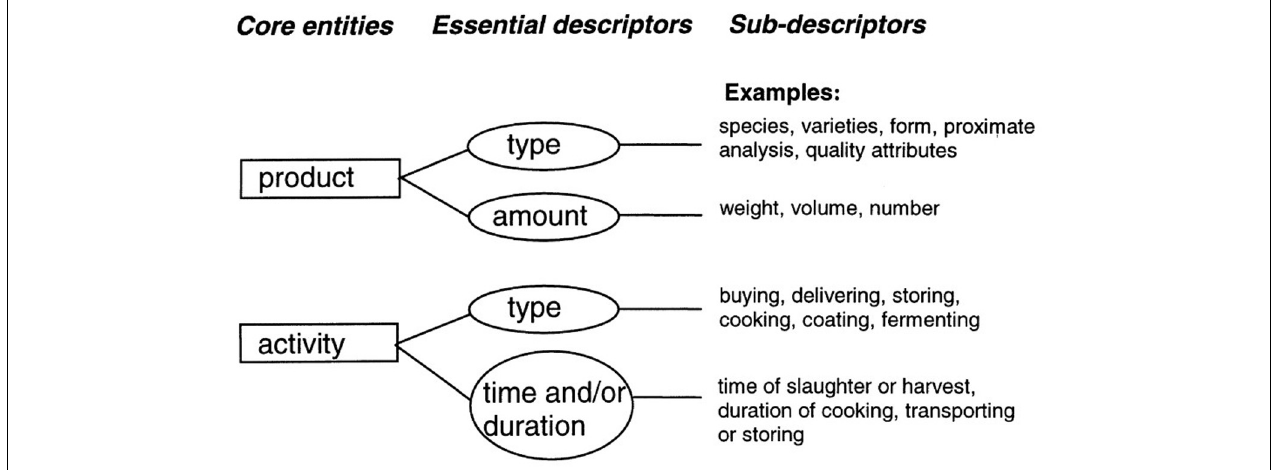
FIGURE 1 | Fundamental structure of a traceability system. Reprinted from “Perspectives on Traceability in Food Manufacture,” by Moe, 1998, Trends in Food Science and Technology, 9 (5), 211–214. Copyright 1998 by Elsevier Science Ltd. Reprinted with permission.